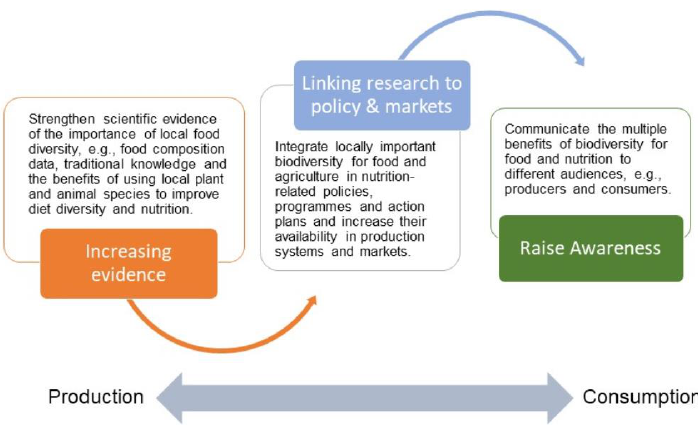
Figure 1. The three-pronged approach used by countries to establish enabling environments for mainstreaming biodiversity for food and nutrition into local food systems, from production to consumption (adapted from [26–28]).